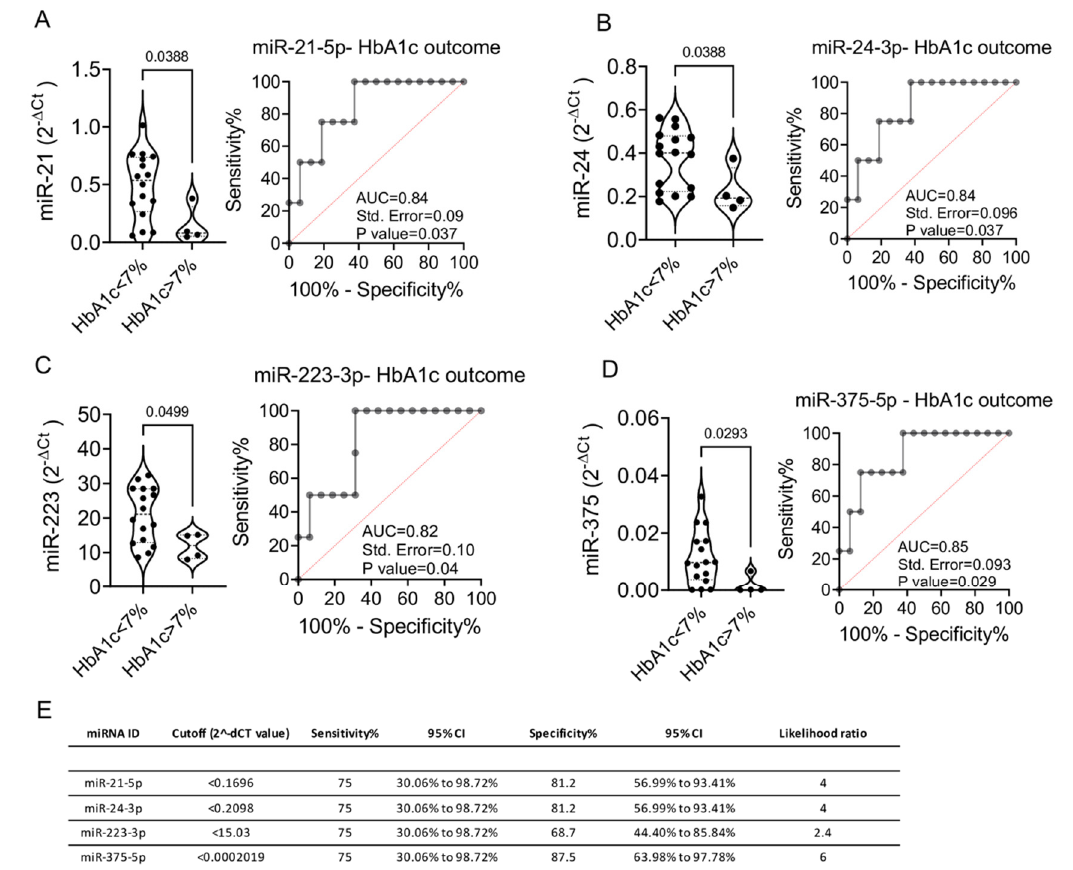
Figure 3. ( A – D ) Baseline expression levels of miR-21-5p ( A ), miR-24-3p ( B ), miR-223-3p ( C ) and miR-375-3p ( D ) in patient with HbA1c levels <7% and >7% at T12. ROC curves for each miRNA are reported alongside with indication of Area under the Curve (AUC), Standard Error and p value. ( E ) Table reporting baseline miRNAs expression sensitivity and specificity in the prediction of HbA1C > 7% outcome using the ROC curve analysis. Statistics using Mann-Whitney U test for non-parametric data, involving comparisons between two